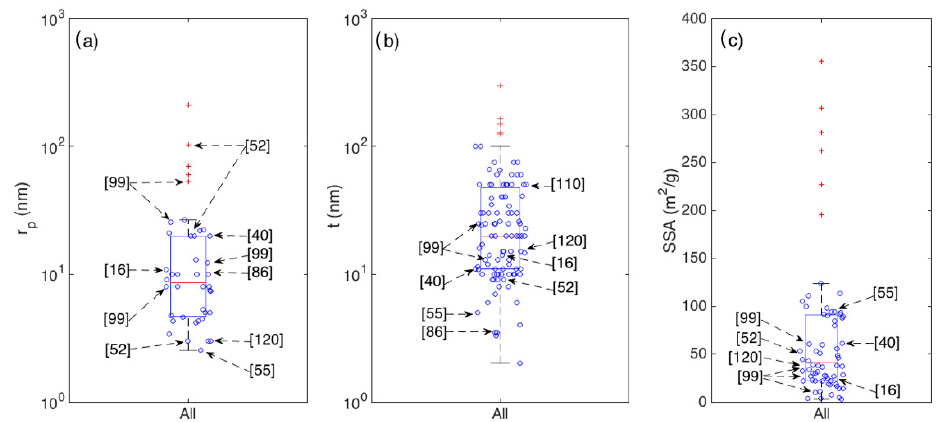
Figure 9. Boxplots showing the statistics of average pore radius r p ( a ); crystallite thickness t ( b ); and Specific Surface Area SSA ( c ), for the whole set of considered articles.